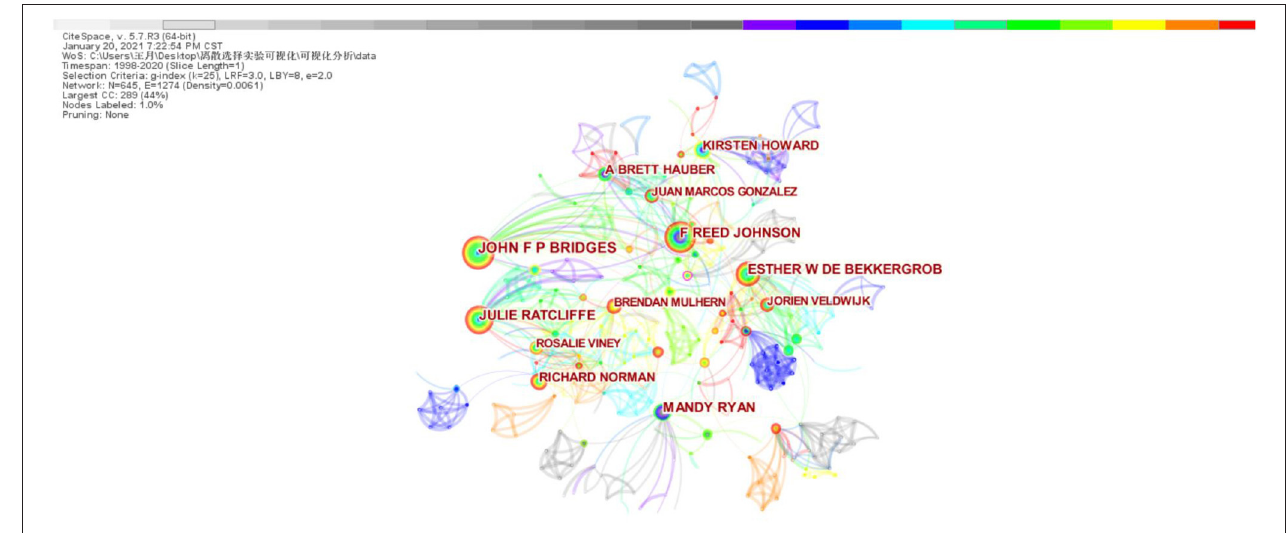
FIGURE 3 | Author collaboration network.